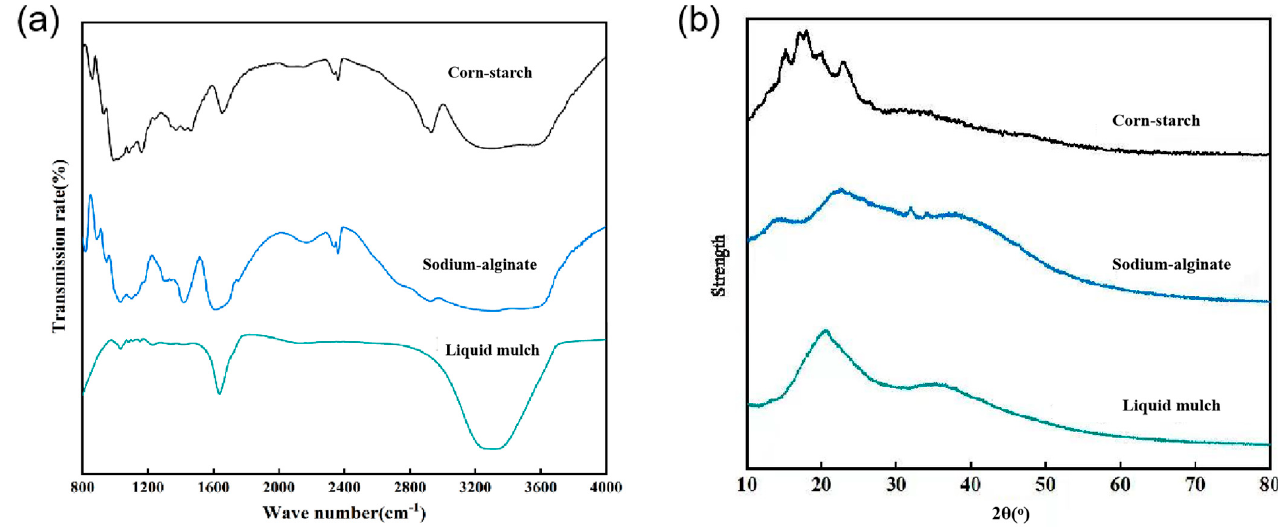
Figure 3. FTIR spectra ( a ) and XRD diffraction images ( b ) of liquid mulch and its main raw materials.